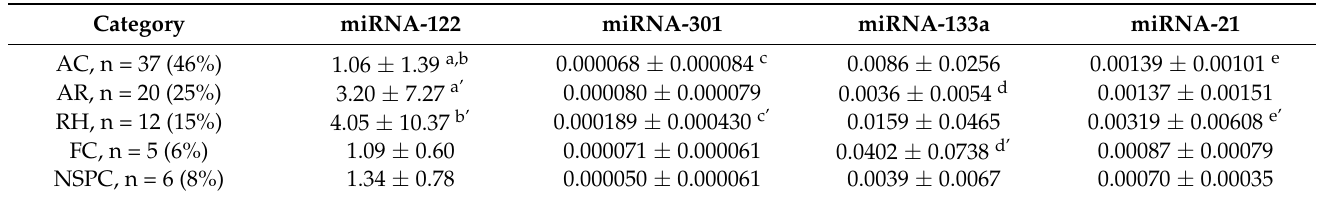
Table 3. Comparison of hepatic micro-RNA levels in different liver graft pathologies in 80 recipients who underwent living donor liver transplantation.